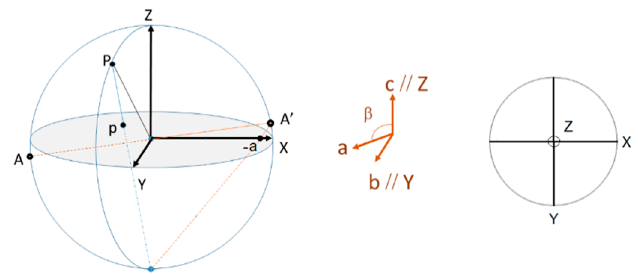
Figure 6. Convention used to plot the monoclinic B19 ′ rotation axes on a stereographic projection (upper sphere). Any point P is projected on a point p on the disk (XY). We use the conventions b B19 ′ // Y and c B19 ′ // Z . Since the direction a B19 ′ intercepts only the lower sphere in A, its opposite in A’ must be used and its projection is noted - a .